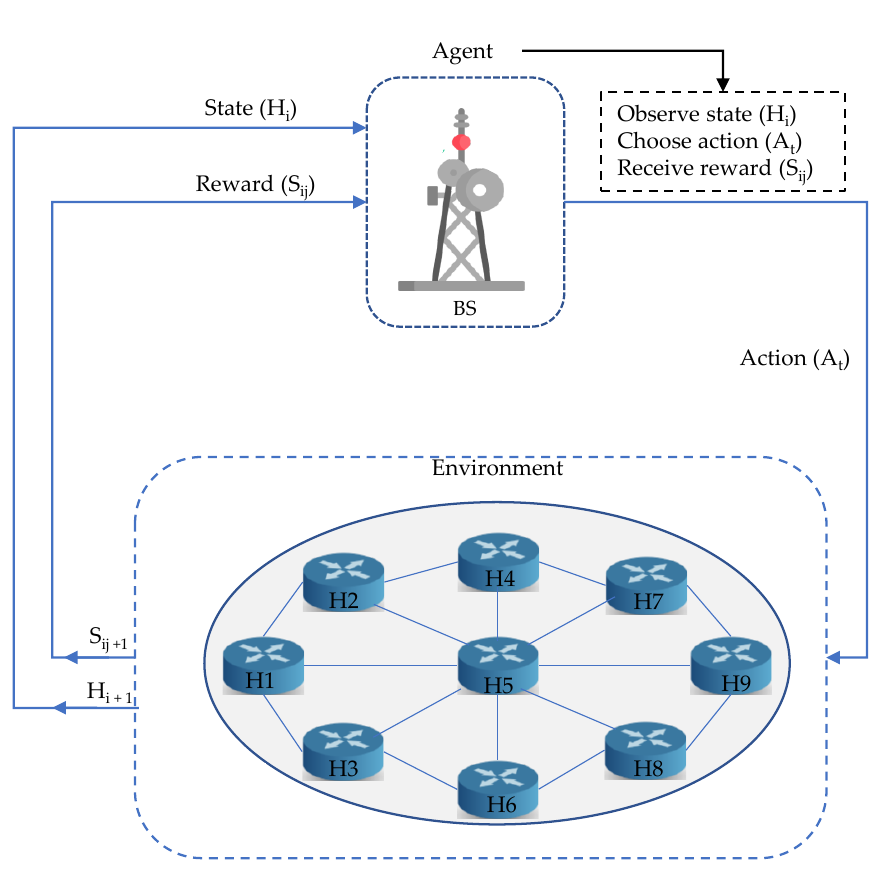
Figure 3. Overview of RL-based stretch reduction